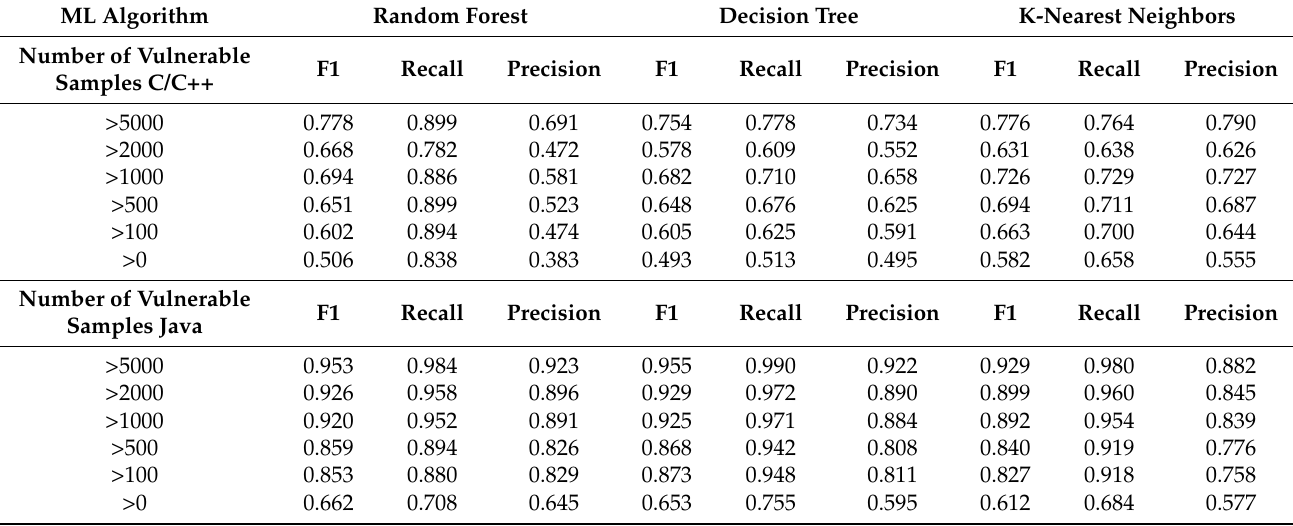
Table 3. Classifier results per number of vulnerable samples (C/C++ and